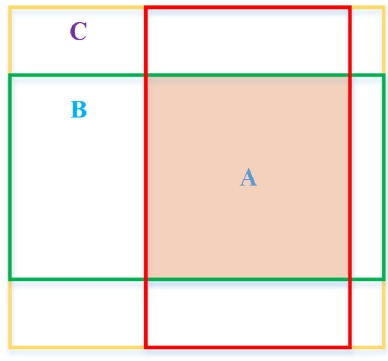
Figure 7. GIoU evaluation diagram.